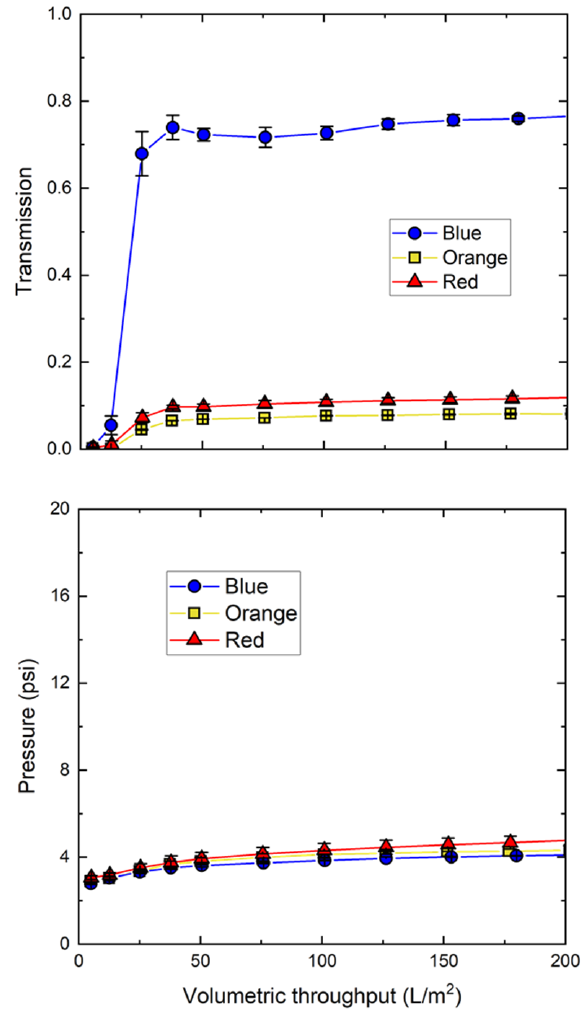
Figure 5. Particle transmission ( top panel ) and transmembrane pressure ( bottom panel ) for the different 30 nm polystyrene nanoparticles during filtration through 0.1 µm mixed cellulose ester membranes at a constant filtrate flux of 150 LMH. Data obtained with suspensions containing 3.4 × 10 12 particles/mL in 10 mM Tris buffer with 0.01% Tween 20.